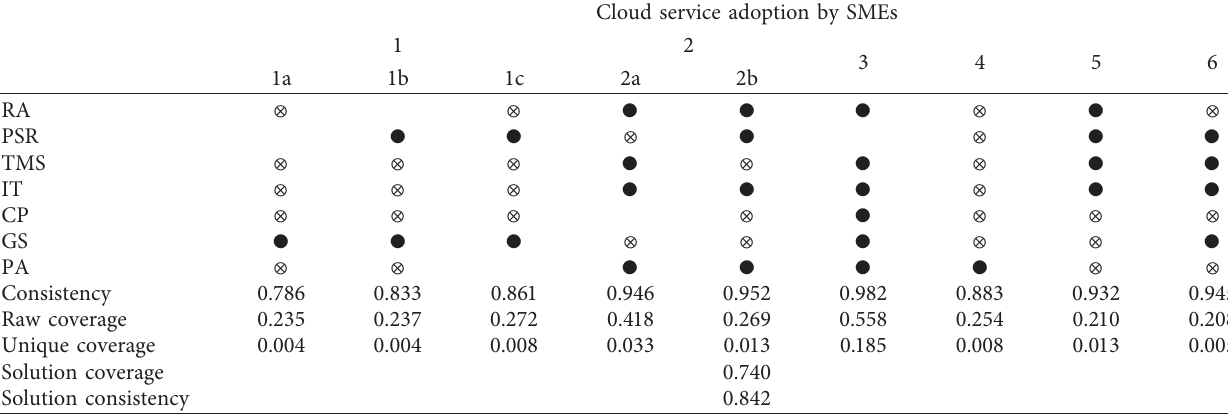
Table 4: FsQCA analysis results. Cloud service adoption by